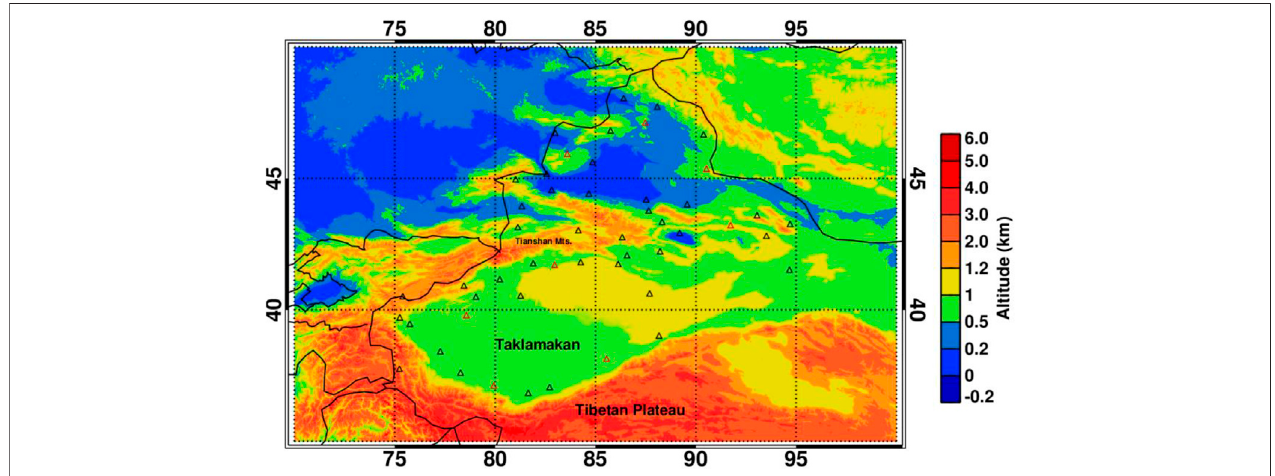
FIGURE 1 | The location of surface observation stations for dust events and the topography of Xinjiang Basin (Triangle: observation station; Red triangle: representative station selected to de fi ne DI).